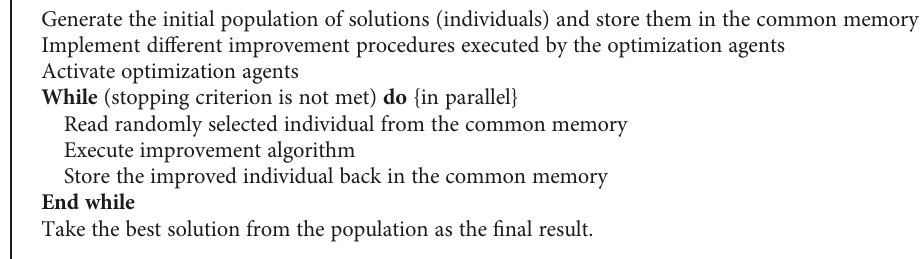
Algorithm 1: Agent-based population learning